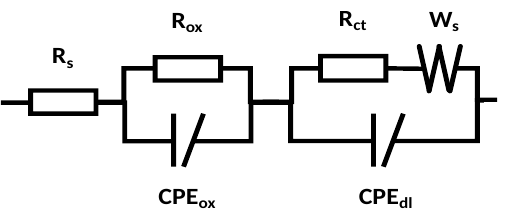
Figure 6. Equivalent circuit used to model the measured impedance